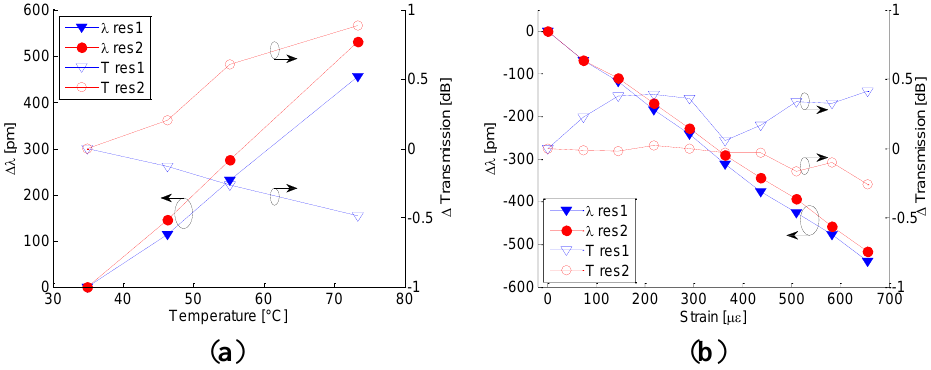
Figure 3. ( a ) Resonant wavelength shifts and peak transmission changes versus temperature. ( b ) Resonant wavelength shifts and peak transmission changes versus